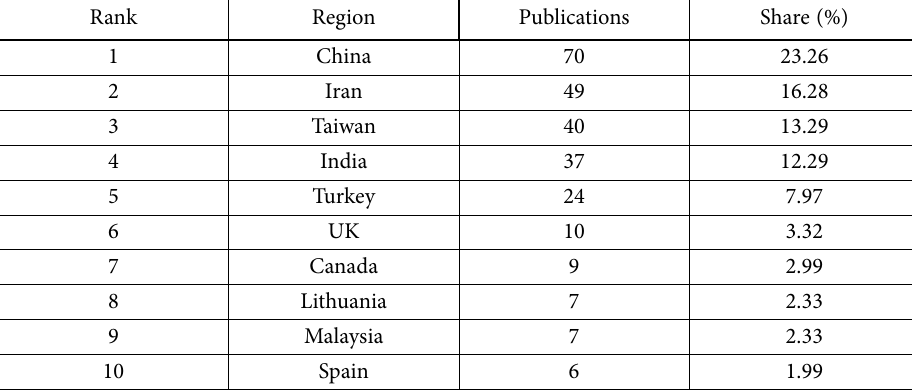
Table 2. Top 10 regions with most publications Rank